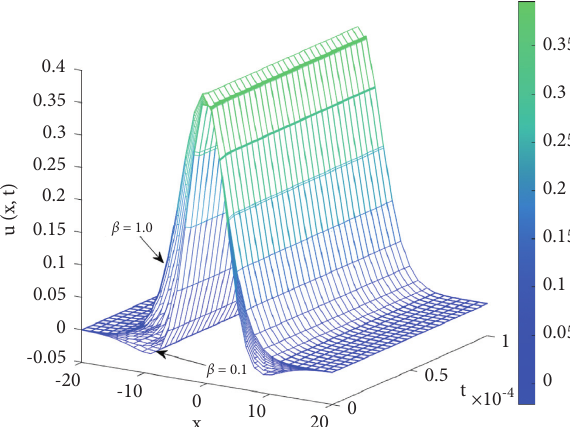
Figure 5: 3D fractional spatial numerical solution u ( x,t ) at order β ∈ ( 0 , 1 ] , κ � 3 , δ � 5.